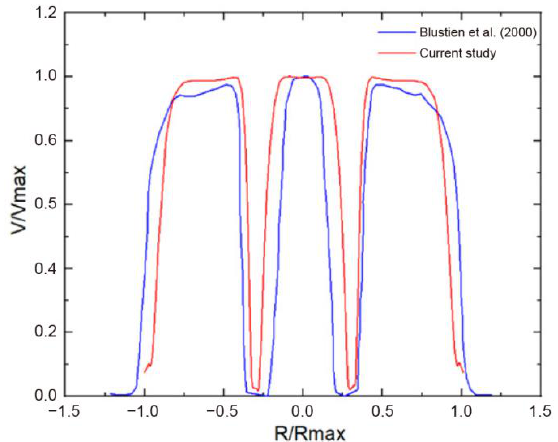
Figure 5. Mesh independence verification.